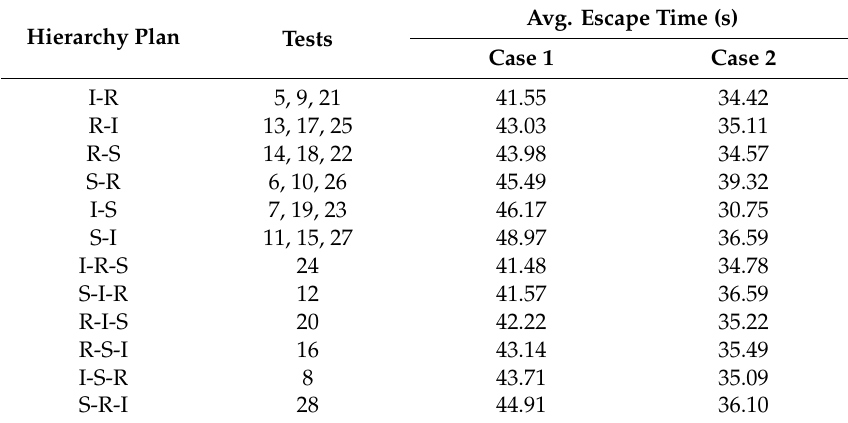
Table 5. Summary of test results with hierarchy